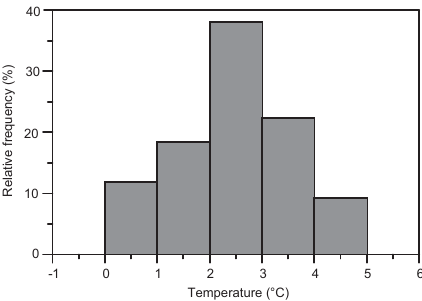
Figure 6. Histogram of the temperature for which σ θ = 27 . 8kgm − 3 for 76 CTD stations in the sill region (station map in Fig.